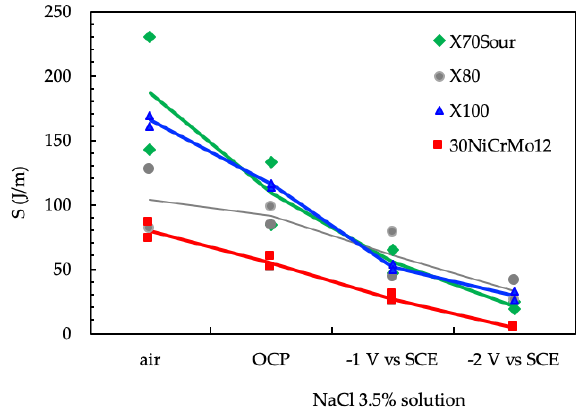
Figure 11. Effect of the environment on the area under the curve J vs. Δa for the tested steel.